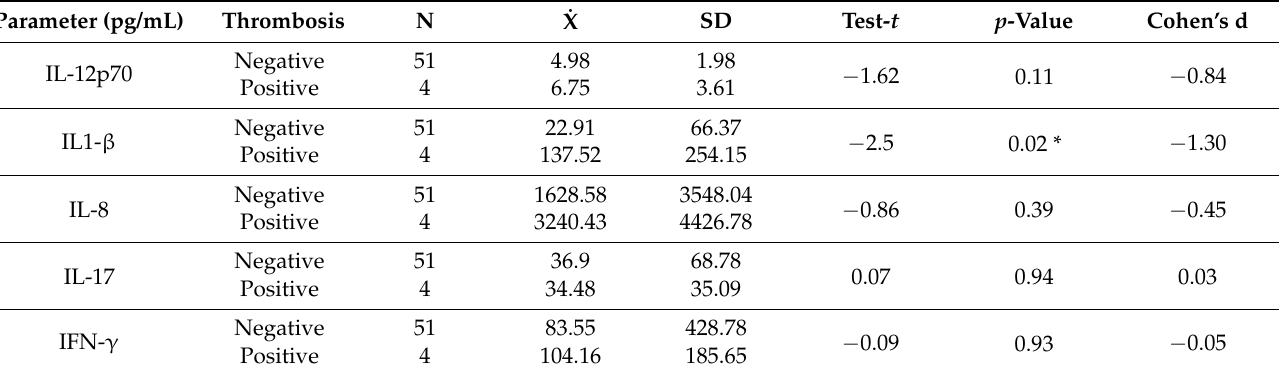
Table 7. Evaluation of cytokines in relation to thrombotic events for patients with suspected COVID- 19 in a hospital in the Tri â ngulo Mineiro region,